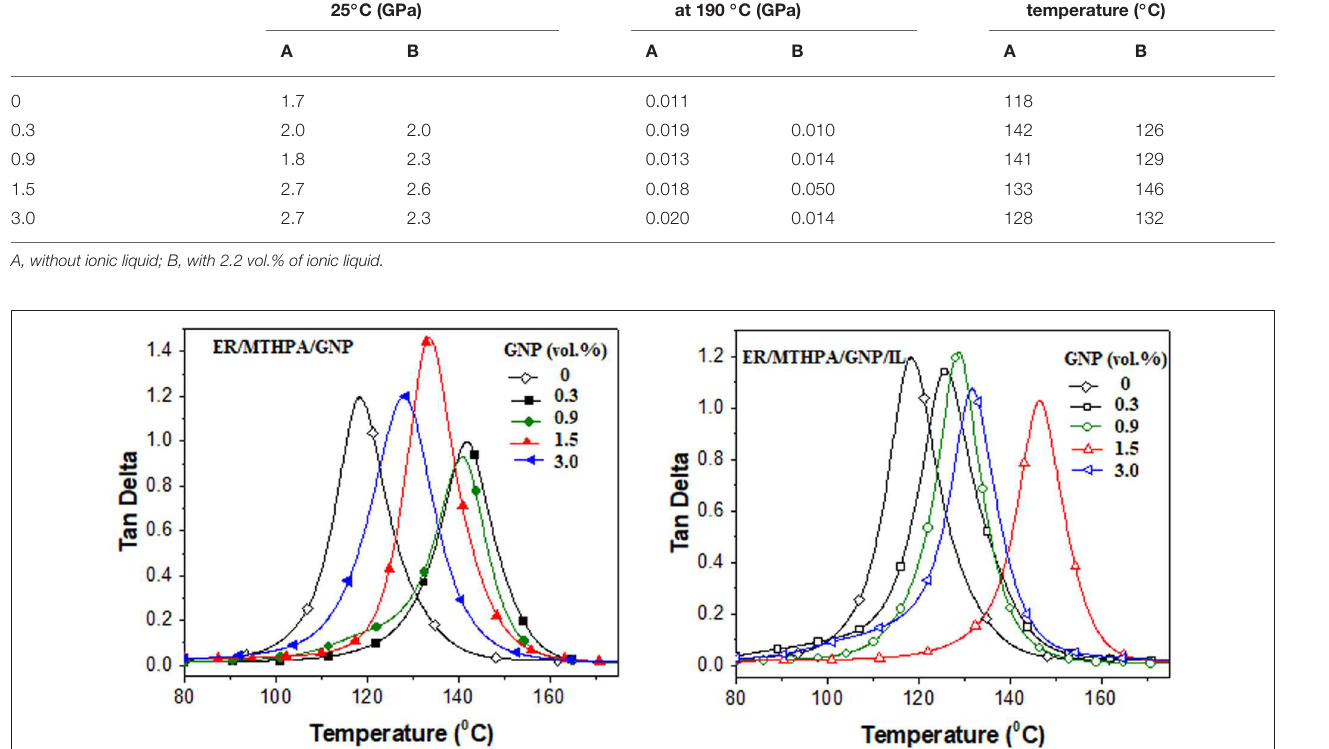
TABLE 4 | Dynamic-mechanical parameters of ER/GNP composites as a function of the GNP content and the presence of ionic liquid. GNP content (vol.%)